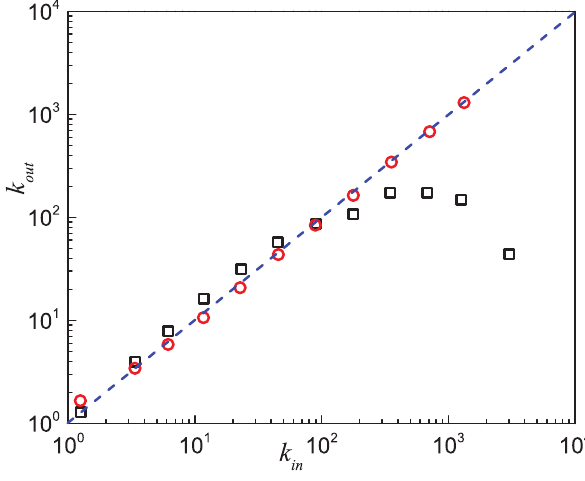
Figure 3. Relationship between the indegree and the out- degree of nodes in the Epinions social network and the model. Results of the Epinions social network (black squares) and simulation results (red circles) based on the model are shown. The blue dash line represents the relation function k in ~ k out . Data points are averages over the logarithmic bins of the indegree k in .